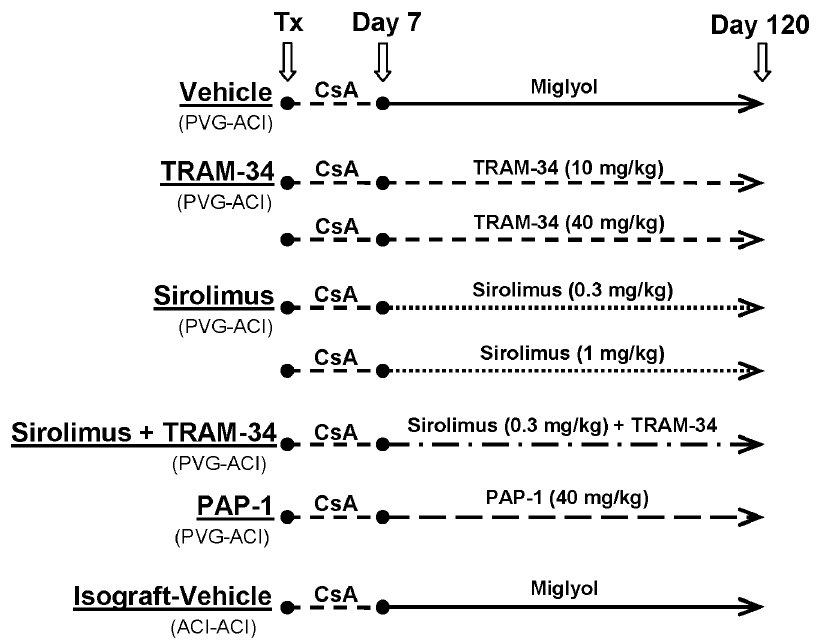
Figure 3. Treatment scheme.